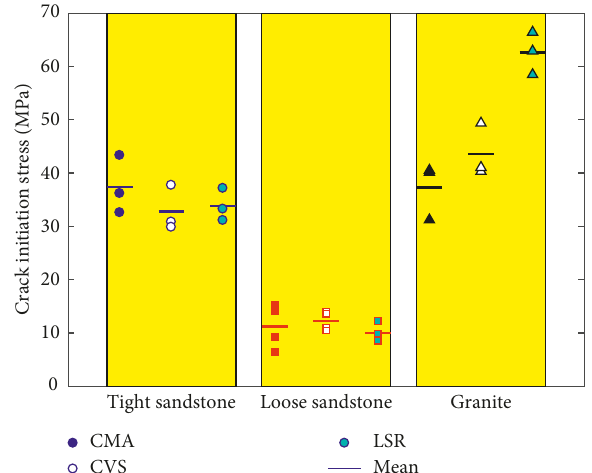
Figure 8: Comparison of crack initiation stresses obtained from different rock specimens and